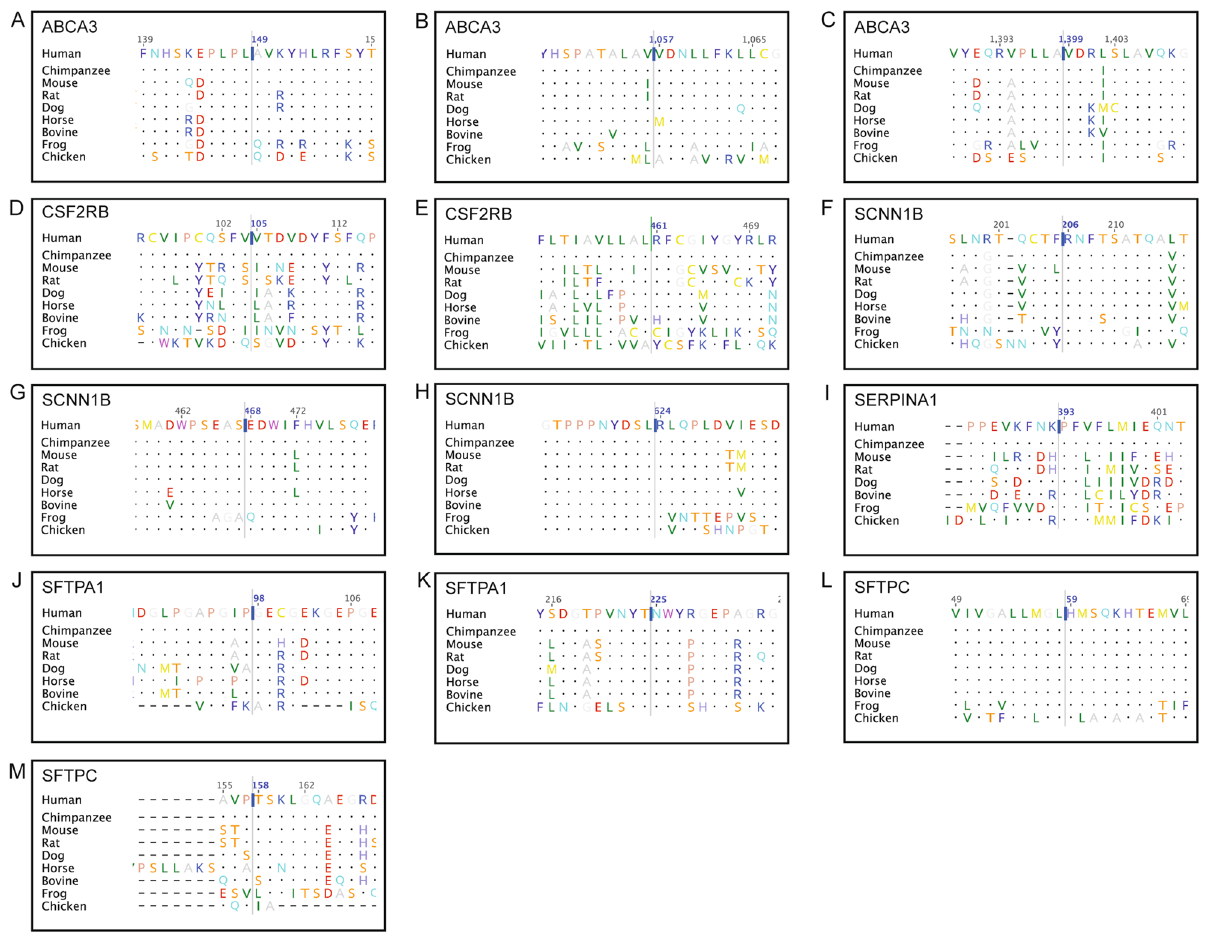
Figure 2. Twenty-one amino acid regions, centered on the missense variation, obtained from a multiple sequence alignment of protein sequences from human, chimpanzee, mouse, rat, dog, horse, bovine, frog, and chicken, where available. ( A ) ABCA3, A1149V (c.446C > T); ( B ) ABCA3, V1057M (c.3169G > A); ( C ) ABCA3, V1399M (c.4195G > A); ( D ) CSF2RB, V105I (c.313G > A); ( E ) CSF2RB, R461C (c.1381C > T); ( F ) SCNN1B, R206W(c.616C > T); ( G ) SCNN1B, E468K (c.1402G > A); ( H ) SCNN1B, R624H (c.1871G > A); ( I ) SERPINA1, P393S (c.1177C > T); ( J ) SFTPA1, G98A (c.293G > C); ( K ) SFTPA1, N225K (c.675C > G); ( L ) SFTPC,